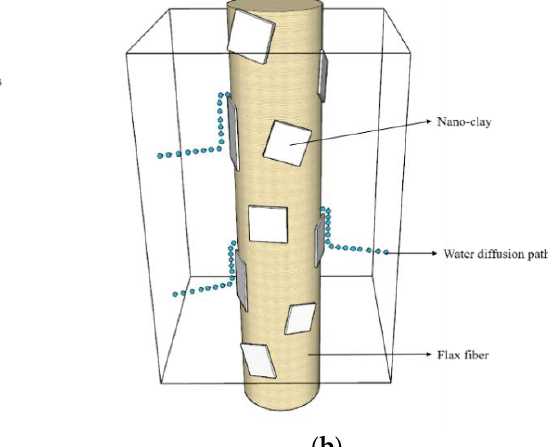
( d ) Figure 7. Diagram of water molecule existence and diffusion path in FFRPs ( a ) untreated FFRPs; ( b ) nano-clay grafted FFRPs; model of water molecule interaction on flax fiber-epoxy interface ( c ) untreated flax fibers ( d ) nano-clay grafted flax fibers. 3.3. FBG Monitoring Figure 8 shows the radial and latitudinal strain values of FFRP calculated by the above formulas, which vary with the time it is placed in the 70 °C under 80% RH environment. Because FBG is sensitive to strain and temperature changes, there are fluctuations in the test results. In order to facilitate the analysis of the results, FBG is used to process the collected data, and the results are simplified to 100 data points without changing the trend. In Figure 8, O/W and C/W represent the weft strain (with less fibers) change process of nano-clay grafted and untreated FFRP; O/R and C/R represents radial strain test results of FBG in nano-clay grafted FFRP and untreated FFRP. The maximum strain in the radial and weft directions of the nano-clay grafted FFRPs are smaller than that of the untreated FFRPs. As the FFRP is placed in a hygrothermal environment for extended periods of time, water molecules gradually enter the fibers, causing them to expand. With the increase of water absorption, the water molecules diffuse into the specimen through the resin, fibers and the interfaces between them. The water ingress plasticizes the resin matrix, and even the fibers, leading to relaxation of the internal strain [31]. Consequently, the internal tension strain gradually reduces. When FFRP reaches saturated water absorption, the FFRP internal strain tends to balance after a certain fluctuation. As shown in Figure 8, the nano-clay-modified FFRP causes a decrease in the swelling amount of the fiber due to a decrease in saturated water absorption. Nano-clay grafted FFRPs show better dimensional stability.